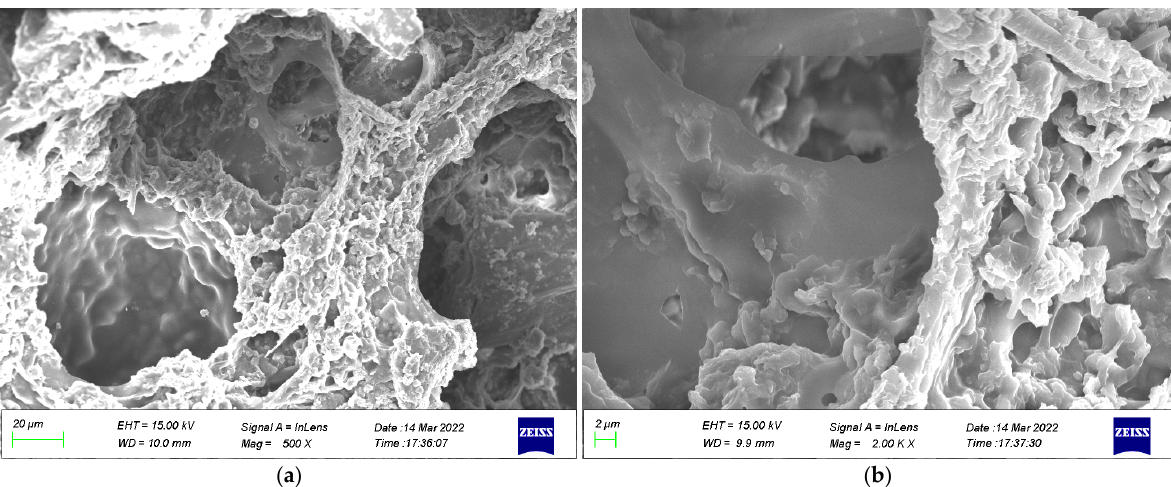
Figure 18. Micro-structure of aggregate, WER content 10%: ( a ) 500×; ( b ) 2000×.